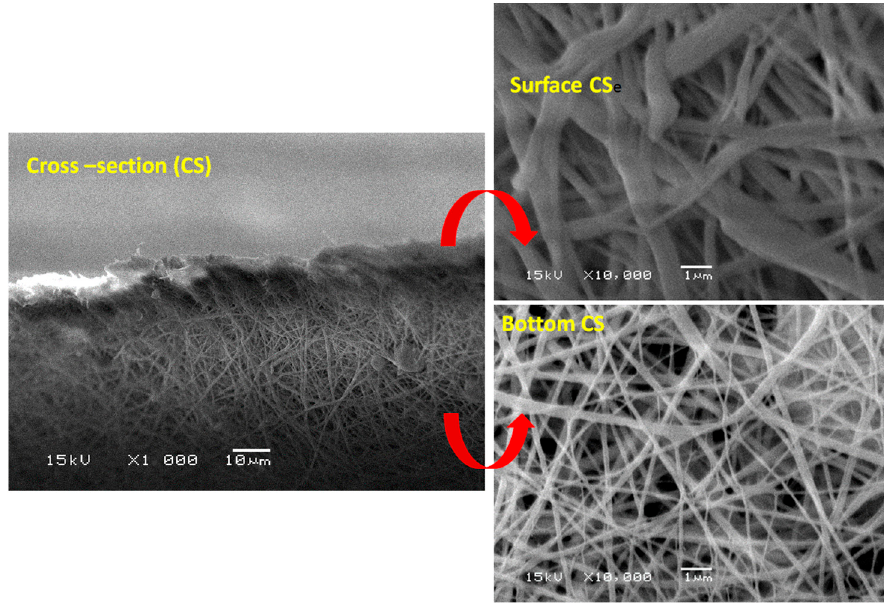
Figure 10. SEM cross-section imaging of PcH/PES blend membranes post-treated by phase inversion at 40 °C. ×1000 and ×10,000 were used.